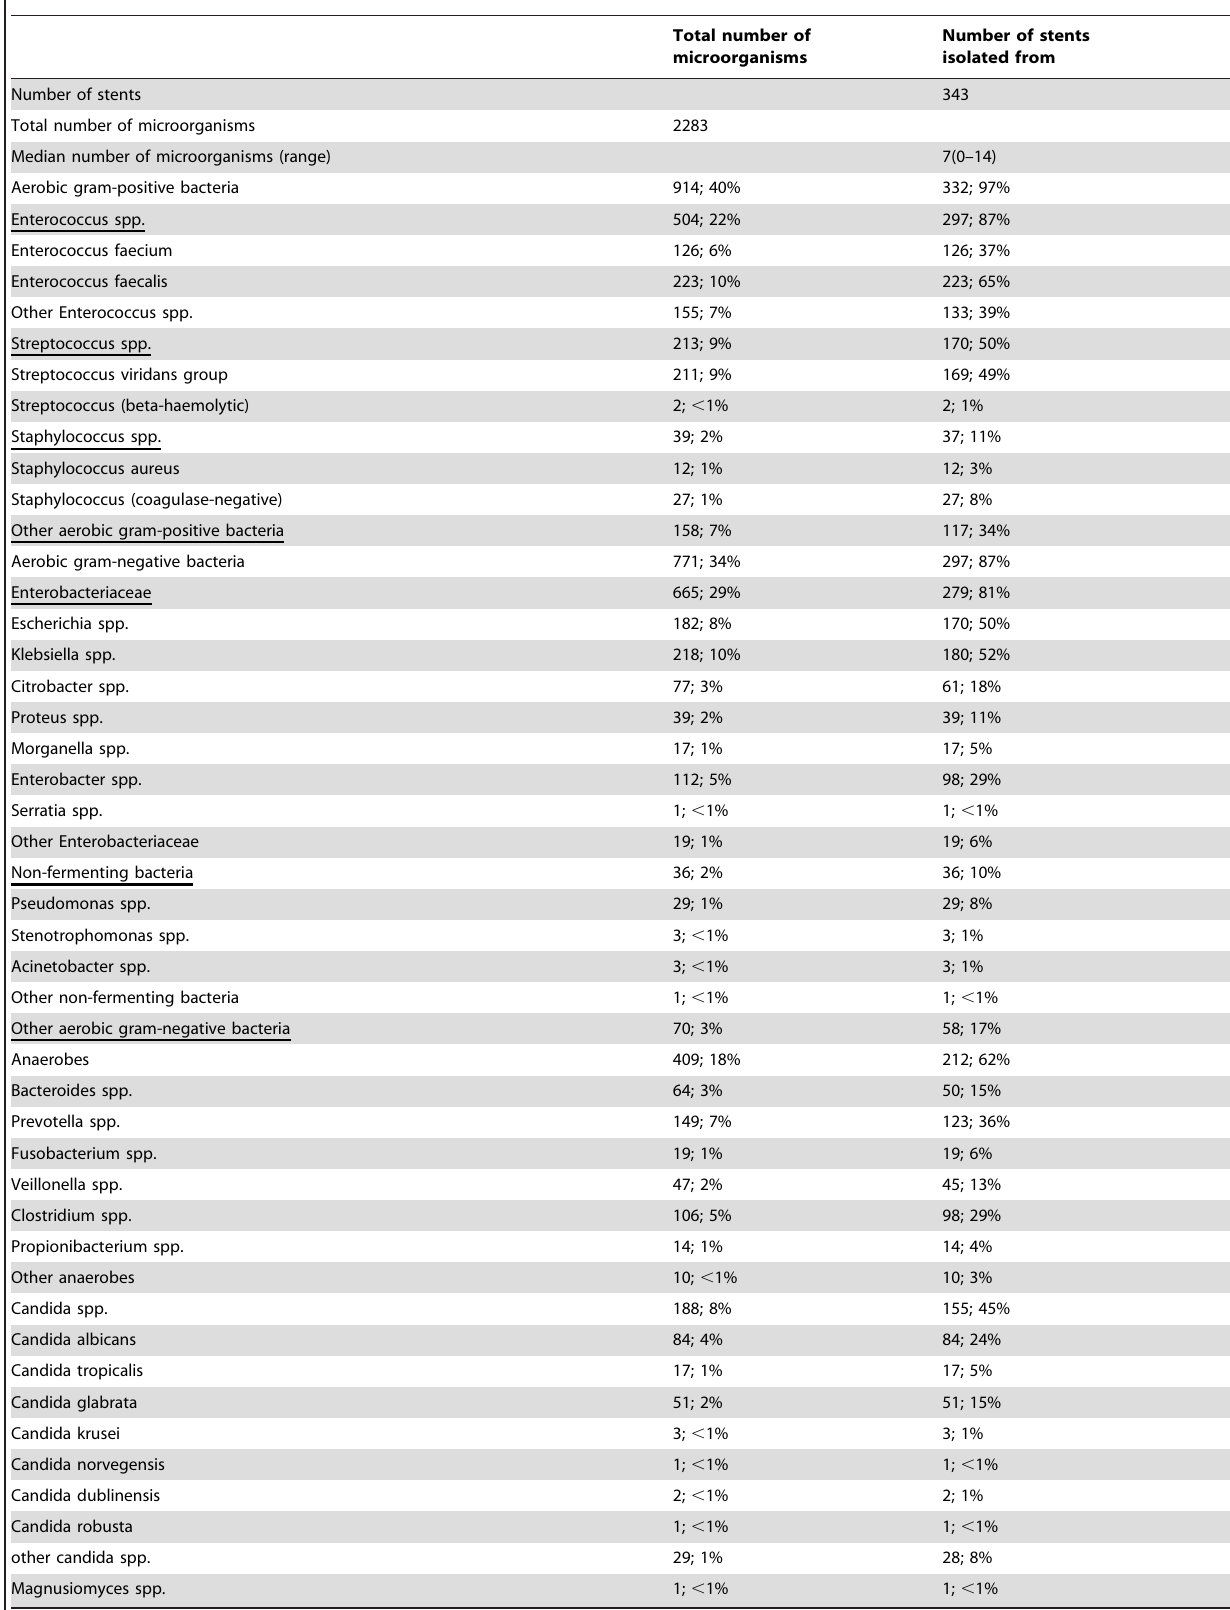
Table 2. Spectrum of microorganisms isolated from the biliary stents.